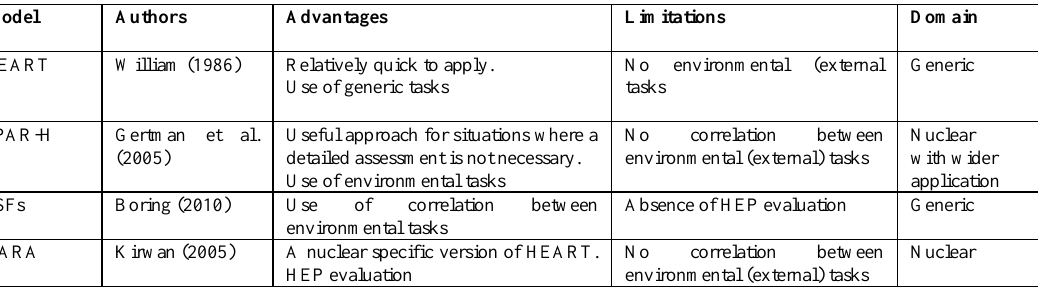
Table 1. Conventional HRA